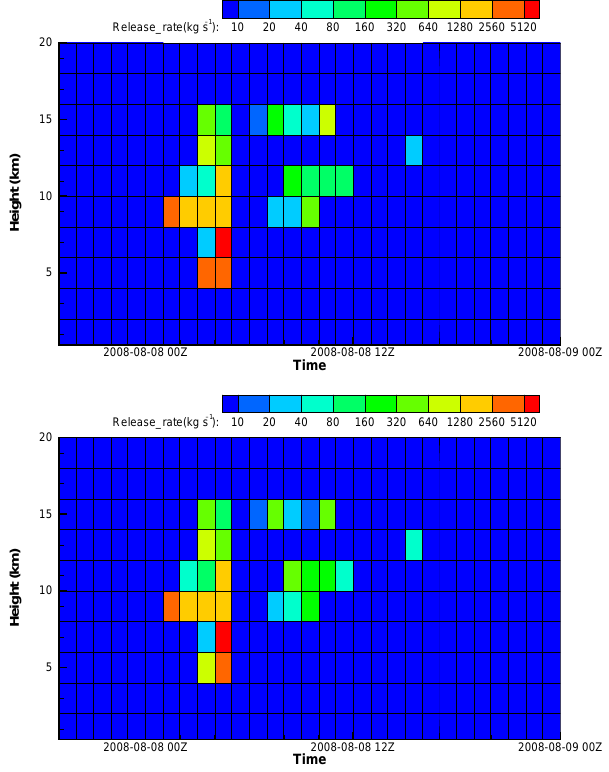
Figure 3. Volcanic ash release results with different a priori er- ror estimations (top, σ ij ≈ 2 . 8 × 10 5 kgs − 1 ; bottom, σ ij ≈ 2 . 8 × 10 9 kgs − 1 ). The TCMs for the emission inverse were generated us- ing HYSPLIT runs with GDAS meteorological data. Only the ash cells from the satellite data at G1 and G2 are used in the emission inverse. The model counterparts are obtained by integrating from the surface to the ash cloud top heights at ash cells.